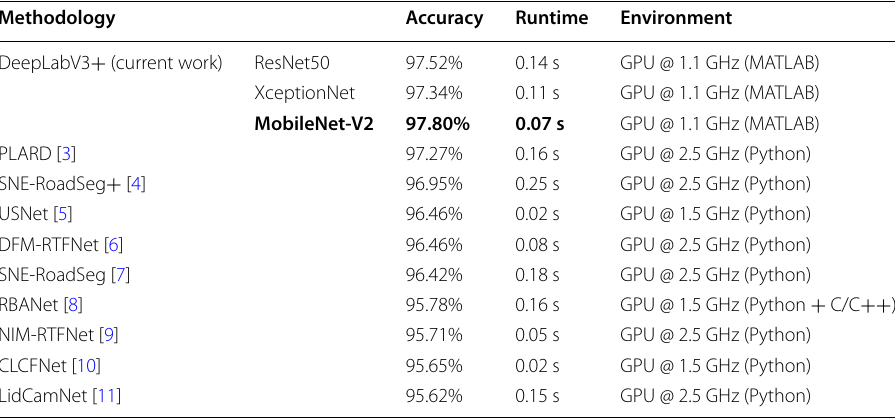
Table 5 Overall accuracy comparison Methodology Accuracy